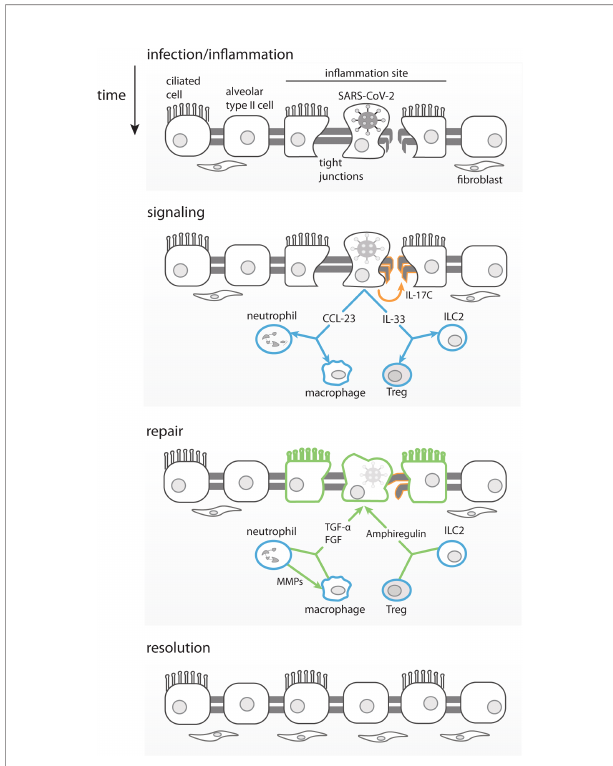
FIGURE 6 | Proposed Model for Asymptomatic SARS-CoV-2 infection. Infected lung epithelial cells induce an in fl ammatory response and mild damage in the pulmonal tissue barrier through tight junction disruption. The immune mediators produced in this context, such as IL-33, can stimulate ILC2 and Tregs to produce amphiregulin and promote tissue repair. IL-17C produced by epithelial cells would also contribute to the lung repair, by stimulating tight-junction proteins production. Chemokines such as CCL23 once produced by infected epithelial cells would recruit neutrophils and promote local differentiation of macrophages. MMP-10 produced by neutrophils would alternatively activate macrophages. Both, macrophages and neutrophils produce FGFs and TGF- a leading to fi broblasts recruitment, growth and promoting lung epithelial barrier repair,